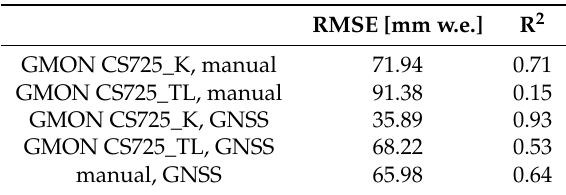
Table 1. Statistical comparison of SWE derived by GNSS, two GMON sensors (CS725_K and CS725_TL), and manual snow pits on a weekly basis at the NEIGE testsite at Forêt Montmorency. RMSE [mm